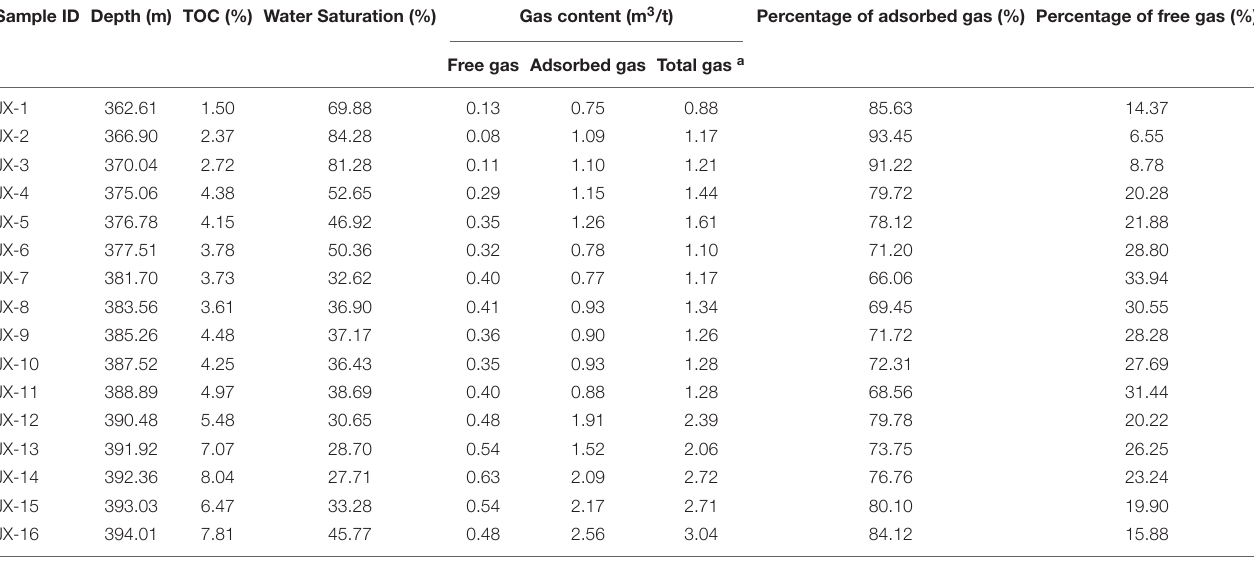
TABLE 3 | Calculated data of water saturation, and absorbed and free gas contents of the studied shale samples. Sample ID Depth (m) TOC (%) Water Saturation